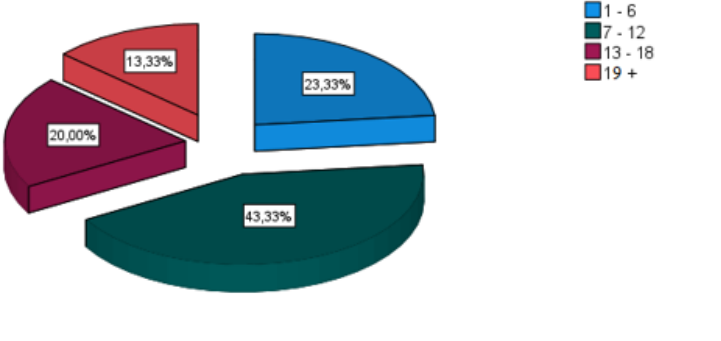
Figure 3. Pie chart presenting the distribution of respondents’ teaching